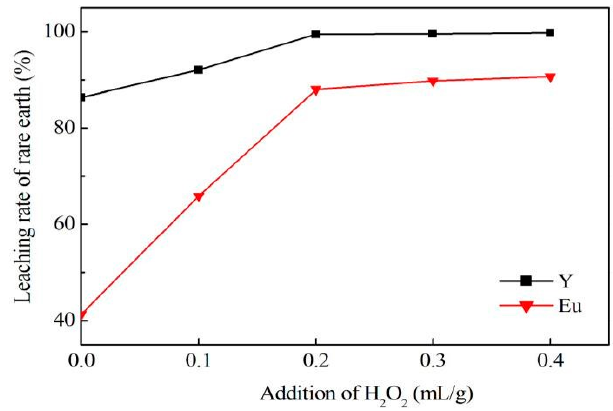
Figure 2. Effect of the addition of hydrogen peroxide on the REE leaching test (4 mol/L HCl concentration, 60 ° C leaching temperature, 4 h leaching time).